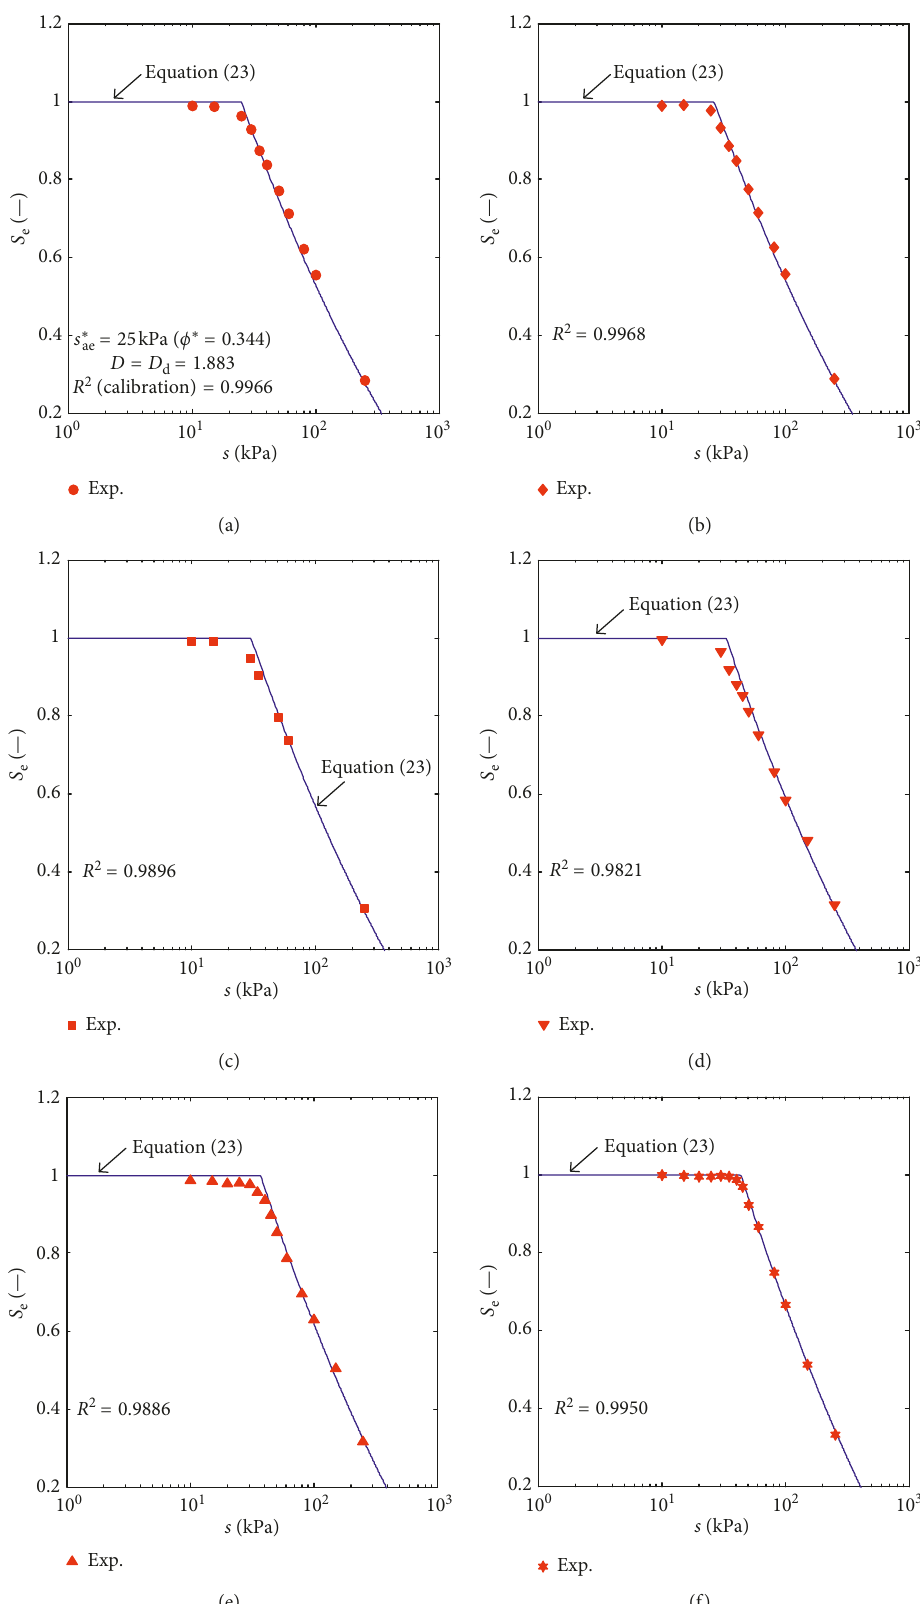
Figure 4: Measured and predicted SWRCs for silty sand with different initial void ratios (data after Huang et al. [63]): (a) e � 0.525; (b) e � 0.513; (c) e � 0.490; (d) e � 0.474; (e) e � 0.454; (f) e �